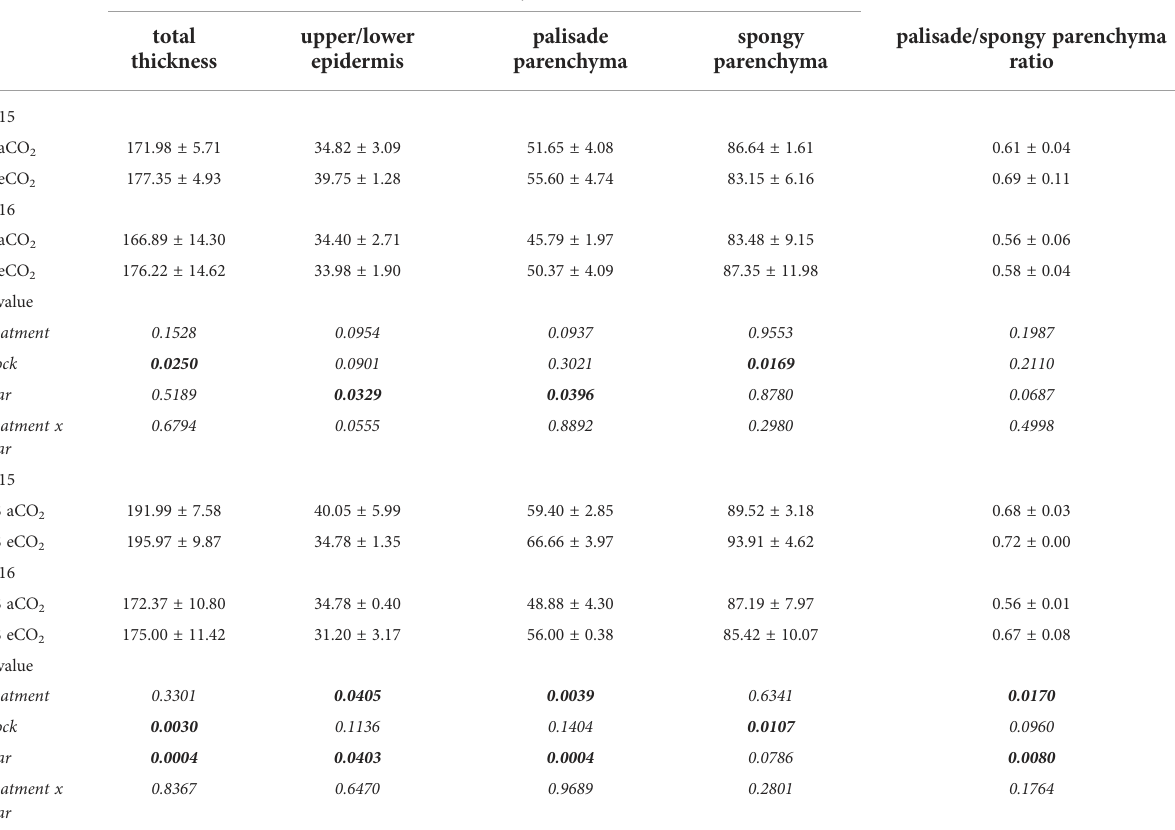
TABLE 3 Thickness of total leaf tissue, palisade parenchyma, spongy parenchyma and ratio of palisade to spongy parenchyma of the two cultivars Riesling (R) and Cabernet Sauvignon (CS) under aCO 2 and eCO 2 conditions. Thickness [µm] total upper/lower palisade spongy palisade/spongy parenchyma thickness epidermis parenchyma parenchyma